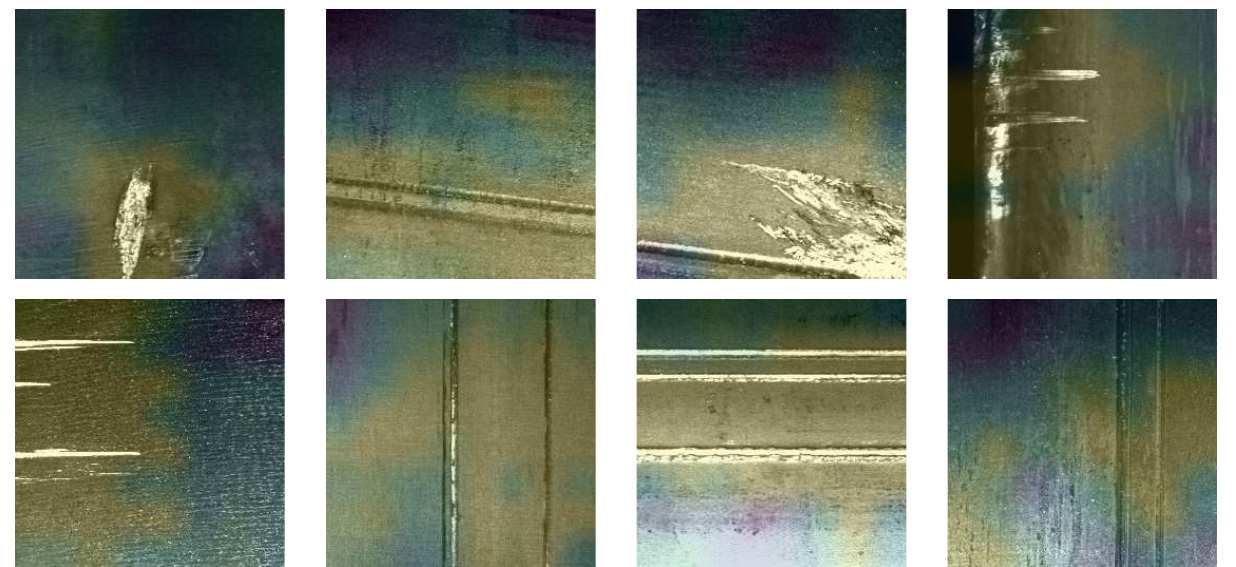
Figure 8. Visualization of activation maps of neurons when damage is